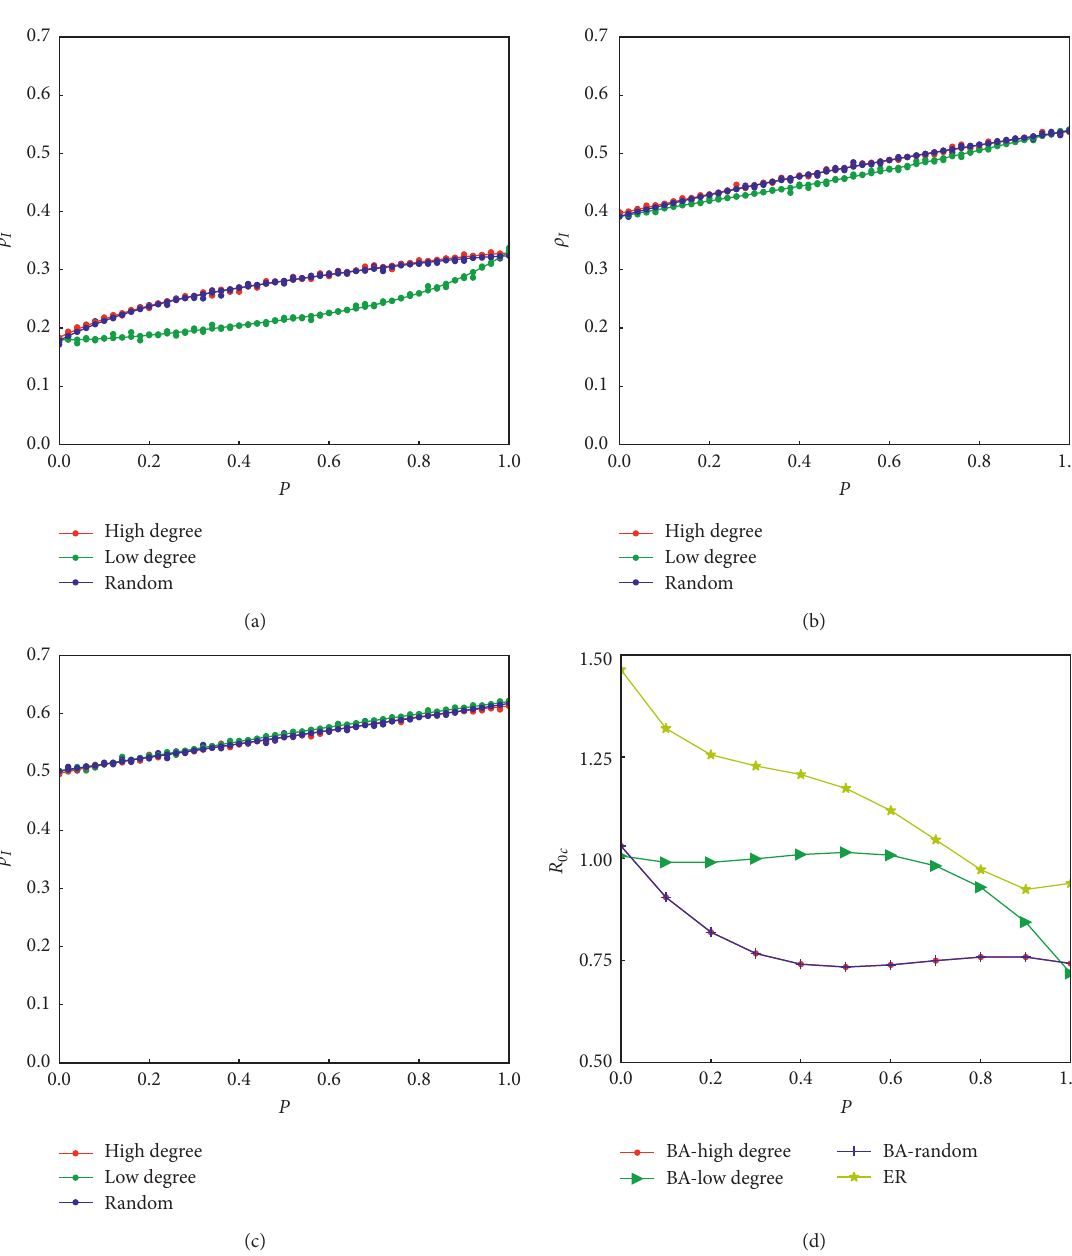
� 1 . 25, (b) R � 2 . 5, and (c) R � 3 . 75. 0 0 0 for epidemic outbreak in different 0 c